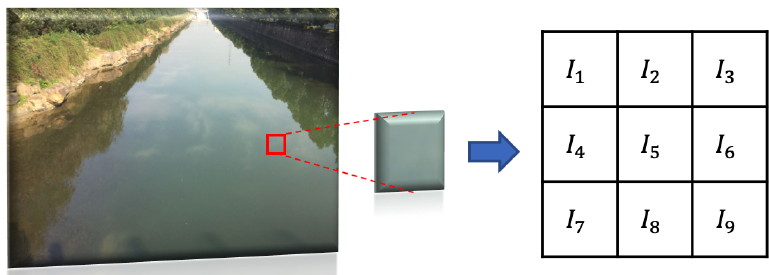
Figure 5. Illustration of generation of image